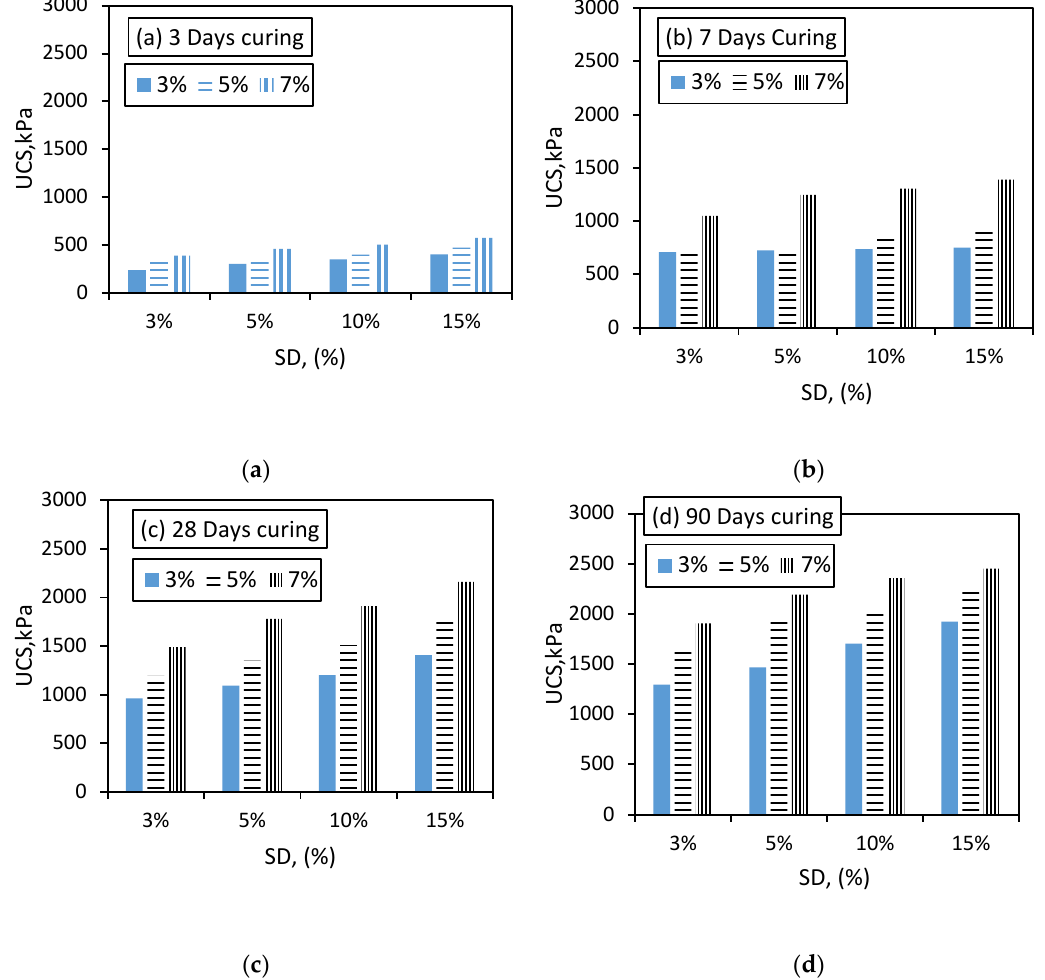
Figure 10. Effect of sawdust addition on USC peak values before exposure to sulphate: ( a ) 3 days curing; ( b ) 7 days curing; ( c ) 28 days curing; ( d ) 90 days curing.